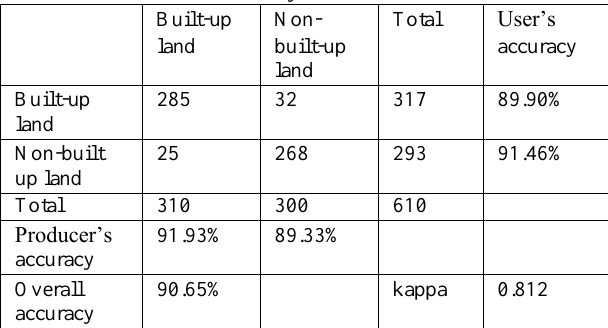
Table 2: Accuracy assessment of IDBI